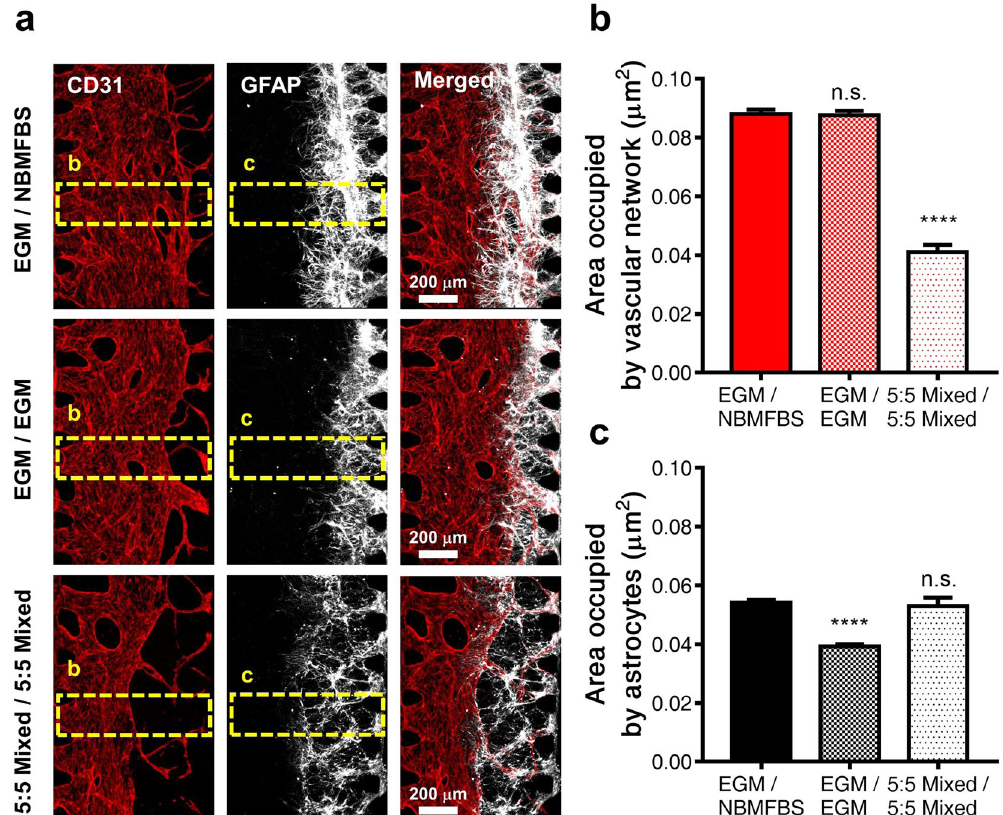
Figure 3. Comparison of vascular network and astrocyte areas in experimental medium co-culture conditions. ( a ) CD31 stained vascular networks shown in red, GFAP stained astrocytes shown in white for all three experimental medium compositions (annotated in VC/NC supplied channels): EGM/NBMFBS; EGM/EGM; 5:5 mix of NBMFBS:EGM for both channels. Vascular network bound media was supplied through the Vascular Channel (VC), and neuron bound media was supplied through the Neural Channel (NC). In the presence of EGM, astrocytes exhibited increased proliferation and migratory behavior. Astrocytes were observed to migrate from the initial neural cell suspension injection zone to the border of the vascular network. ( b ) Average area occupied by the vascular network between a pair of parallel microposts. In cultures where VC was supplied with ECM, (EGM/NBMFBS and EGM/EGM), vascular network areas were roughly equivalent. ( c ) Average area occupied by astrocytes between a pair of parallel microposts. Cultures supplied with NBMFBS via the NC, exhibited the highest astrocytic areas. All data show mean ± SEM. Statistical analysis student’s t-test **** p < 0.0001. 51 ROI for each condition were used for